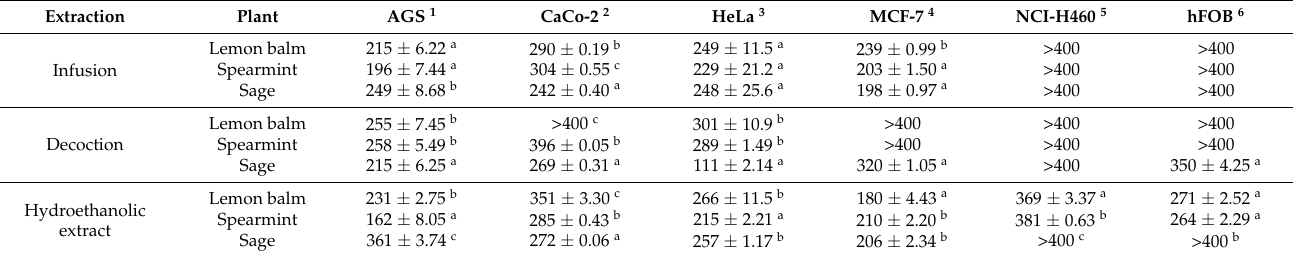
Legend: 1 Gastric adenocarcinoma, 2 Colorectal adenocarcinoma, 3 Cervical carcinoma, 4 Breast adenocarcinoma, 5 Large cell lung carcinoma, 6 non-tumour hFOB (human foetal osteoblasts). Ellipticine GI µ g/mL (AGS), 1.21 ± 0.02 µ g/mL (CaCo-2), 1.91 ± 0.12 µ g/mL (HeLa), 1.02 ± 0.02 µ g/mL (MCF-7), 1.01 ± 0.01 µ g/mL (NCI-H460) and 1.21 ± 0.08 µ g/mL (hFOB). Values with different superscript letters in a column